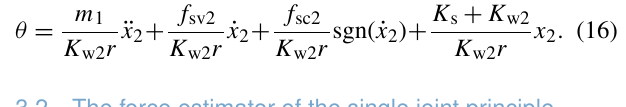
The relationship between the joint angle θ and y 1 , y 2 is shown below, y 1 is the displacement of the positive driving cable which is fixed on the gripper, and y 2 is the displace- ment of the negative driving